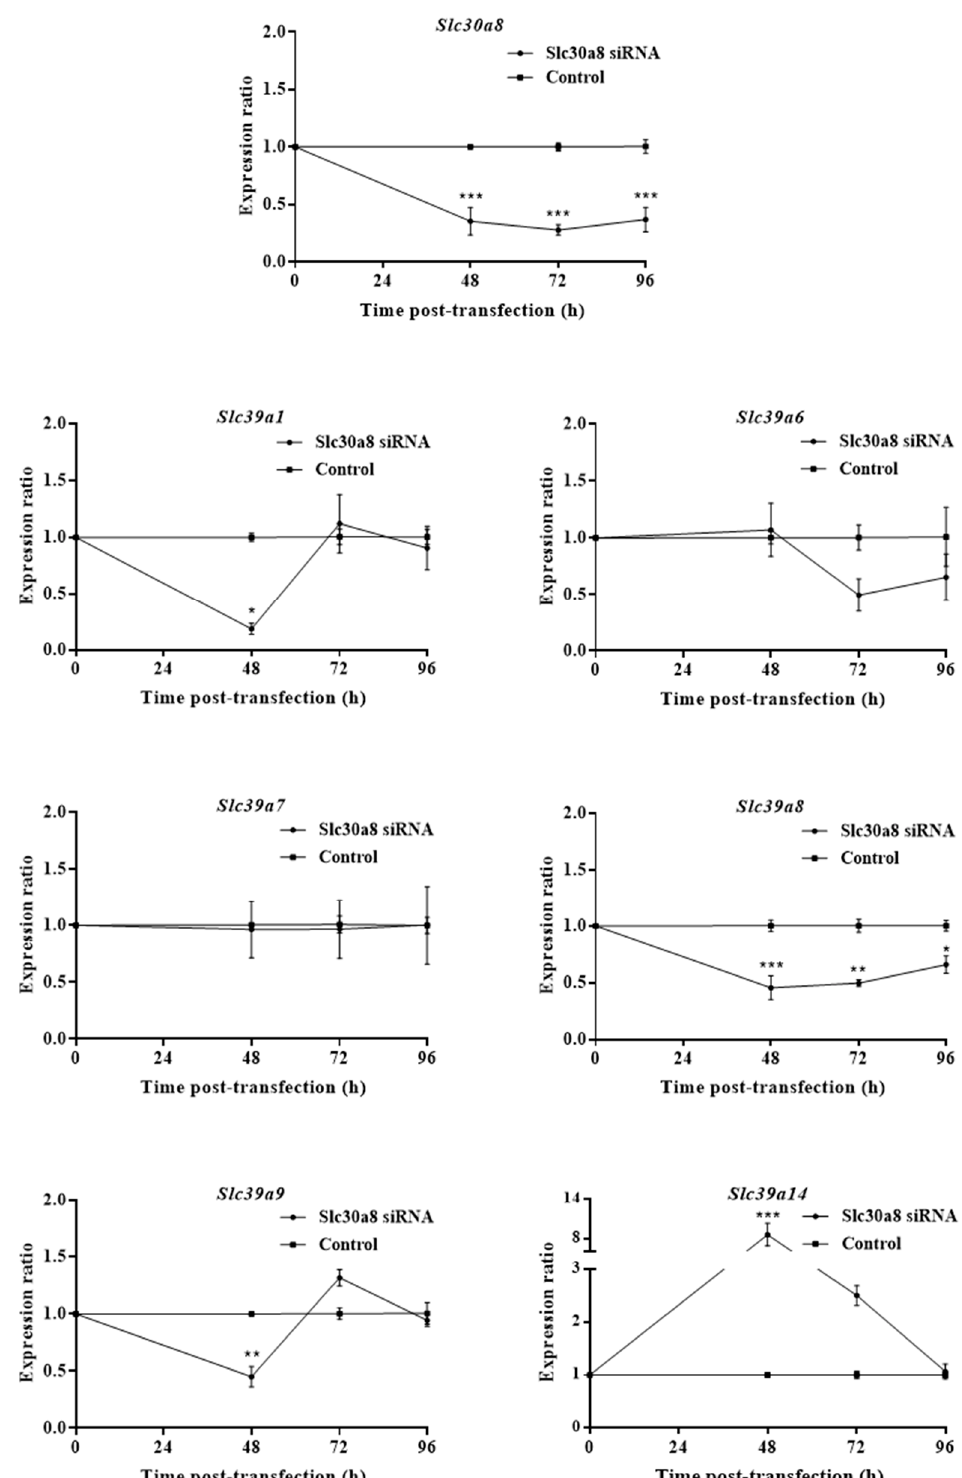
Figure 1. Slc39a zinc transporter mRNA expression following transient Slc30a8 knockdown in MIN6 cells. Time-course for mRNA expression of Slc30a8, Slc39a1, Slc39a6, Slc39a7, Slc39a8, Slc39a9 and Slc39a14 following knockdown of Slc30a8 by siRNA. Expression was assayed at 48, 72 and 96 h post-transfection. Changes in mRNA abundances were calculated through qPCR and presented as expression ratios relative to MIN6 cells transfected with Silencer ® Select negative control siRNA (control) at each time-point. Data were analysed by 2-way ANOVA followed by Sidak’s multiple comparison test. Error bars show ± SEM. n = 3. * p < 0.05, ** p < 0.005, *** p < 0.001.